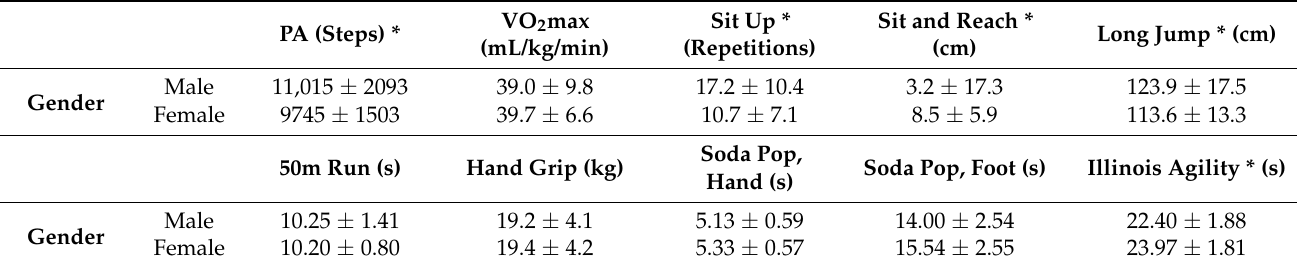
Table 2. Physical activity and physical fitness test measures. Physical activity expressed as the daily average of a 7-day collection period.